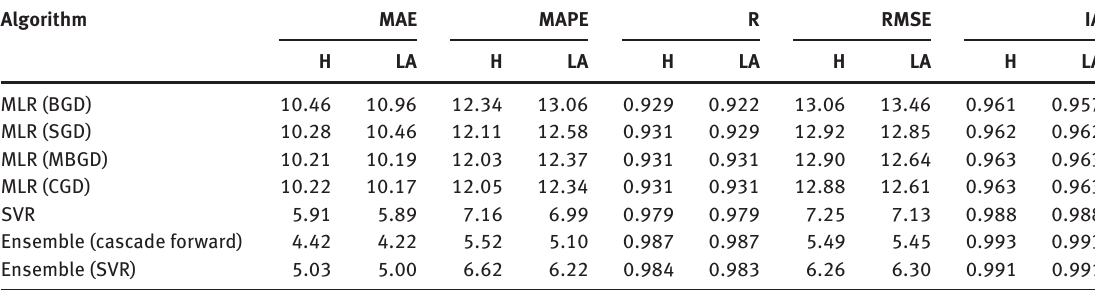
Table 5: Performance of Cascade Forward and SVR Ensembles with Regression Models as the Base Learners.